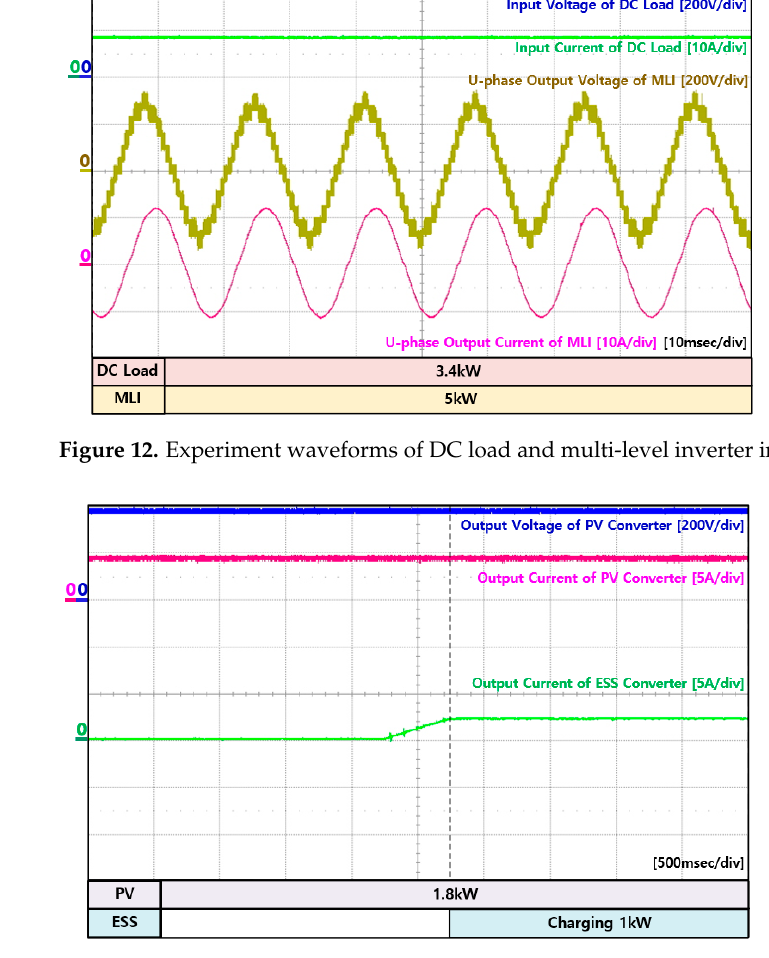
Figure 13. Experiment waveforms of PV converter and ESS converter in mode 1. Table 1. Output power of each power conversion devices in mode